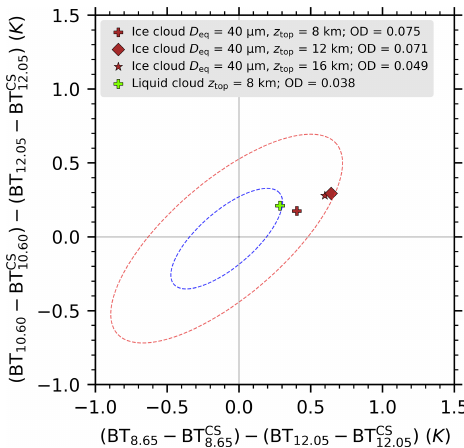
Figure A2. Radiative transfer simulation of the IIR signature of lay- ers detected at 80km horizontal averaging with the largest possi- ble integrated attenuated backscatter. They represent the very worst possible cases that can affect the IIR measurements. We note than even those worst cases do not escape from the clear-sky uncertainty